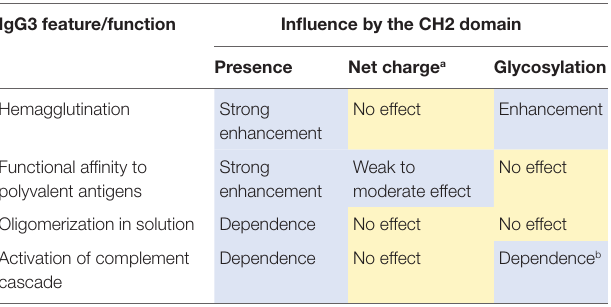
TaBle 6 | Summary of experimental results.